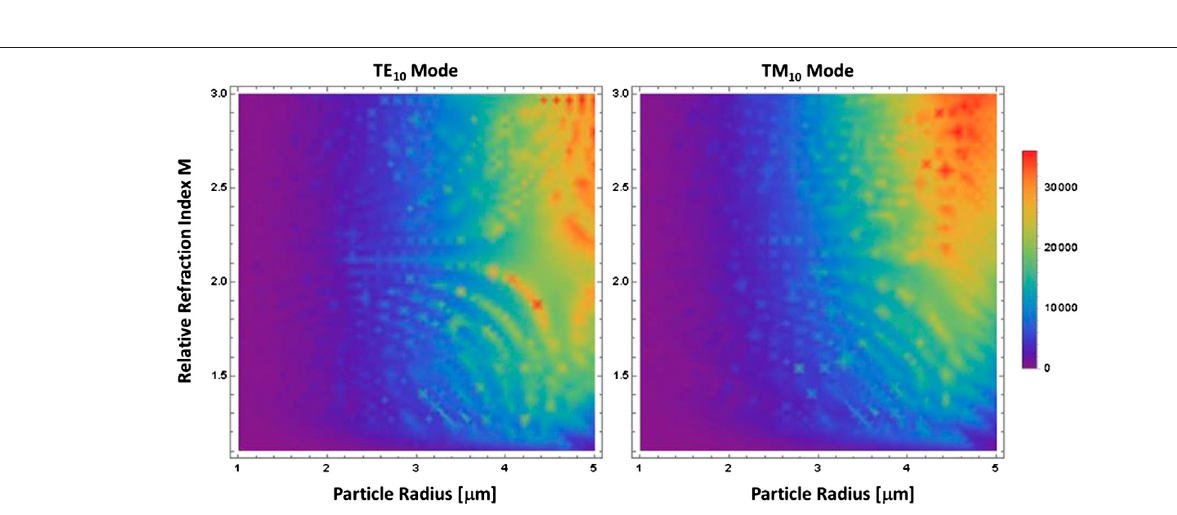
FIGURE 2 | Axial force for: left n (cid:1) 1.3 particle; right n (cid:1) 3 particle. Blue TE 10 mode, red TM 10 mode of a 10 μ m radius cylindrical waveguide.